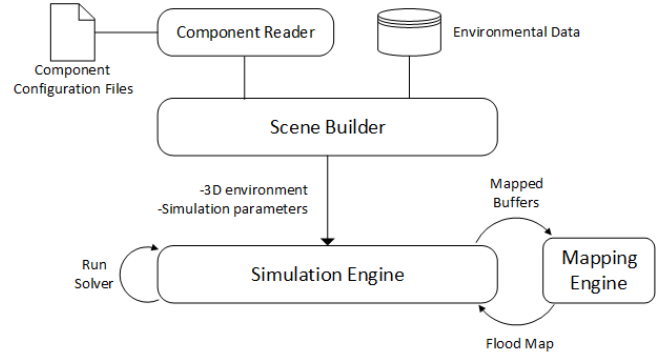
Figure 1. Overview of the system design and data